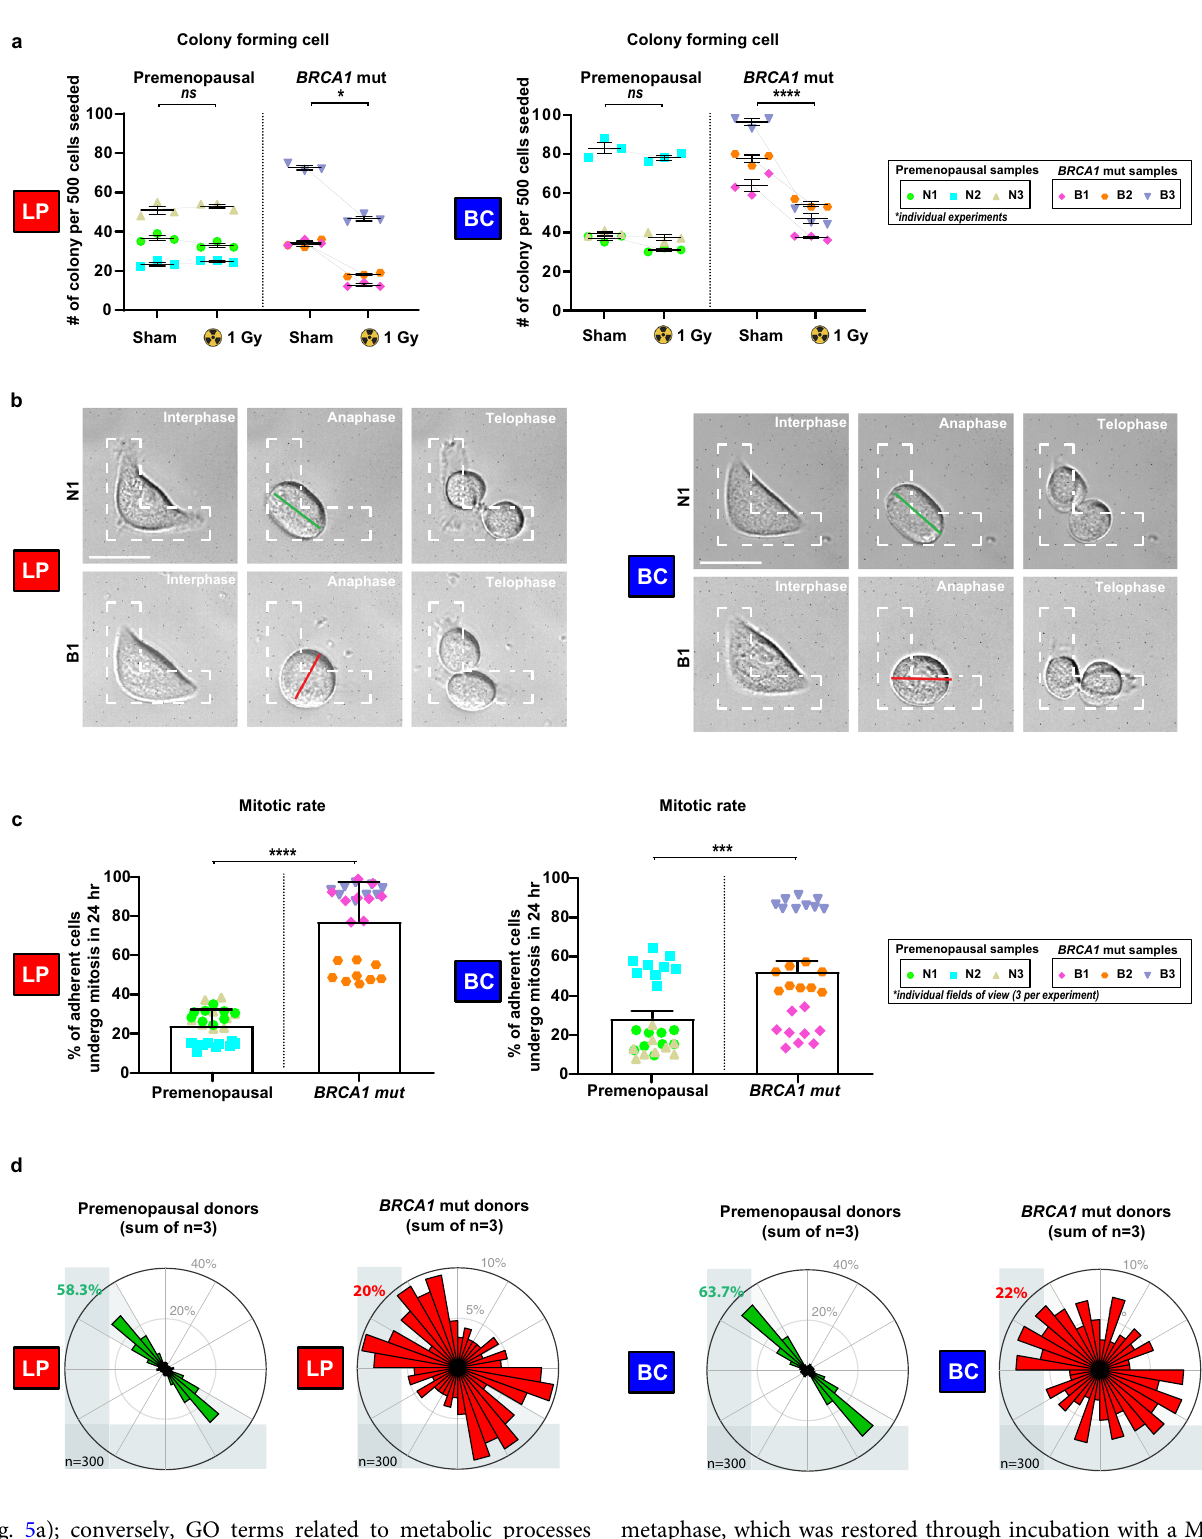
metaphase, which was restored through incubation with a MPS1 inhibitor (100 nM NMS-P715) (Figure S8a-c). However, MPS1 inhibition was not suf fi cient to normalize control of the cell division axis for BRCA1-silenced cells (Figure S8d). Thus, the restoration of normal metaphase kinetics through MPS1 inhibi- tion was not suf fi cient to correctly orient the cell division axis in BRCA1-silenced cells. PLK1 activity at mitotic spindle poles co-ordinates the spindle positioning pathway 21,41 . Total levels of PLK1 and active